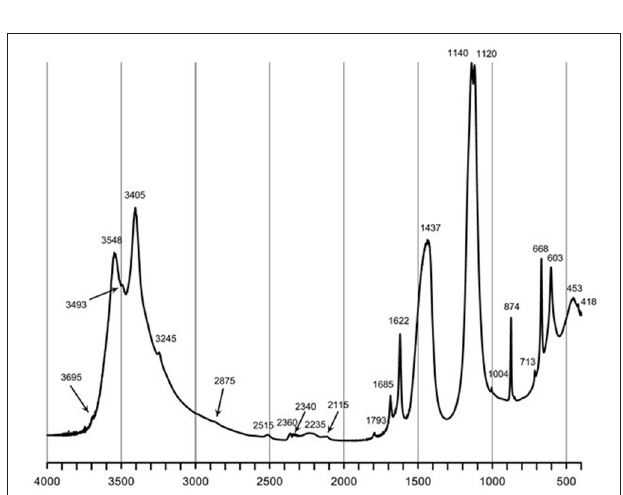
FIGURE 3 | FTIR spectrum of the gBIOs. The numbers denote positions of the absorption bands.